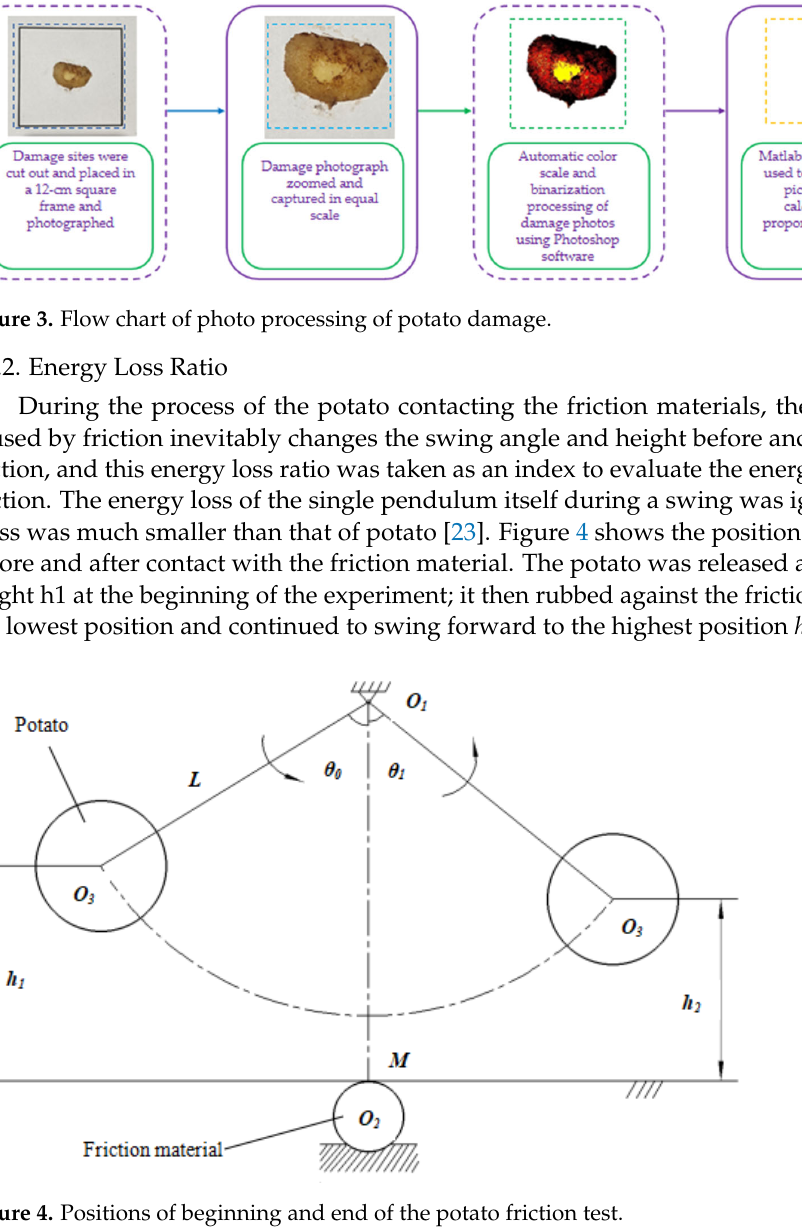
Figure 4. Positions of beginning and end of the potato friction test.